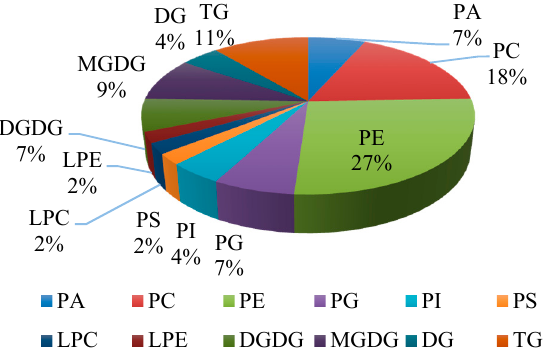
Figure 2. Classification of lipid species with significant differences of banana fruit during chilling injury. The proportions are based on the 45 lipids with significant differences. PA: Phosphatidic Acid; PC: Phosphatidylcholine; PE: Phosphatidylethanolamine; PG: Phosphatidylglycerols; PI: Phosphatidylinositol; PS: Phosphatidylserine; LPC: Lysophosphatidylcholine; LPE: Lysophosphatidylethanolamine; DGDG: Digalactosyldiacylglycerol; MGDG: Monogalactosyldiacylglycerol; DG: Diglyceride; TG: Triglyceride.